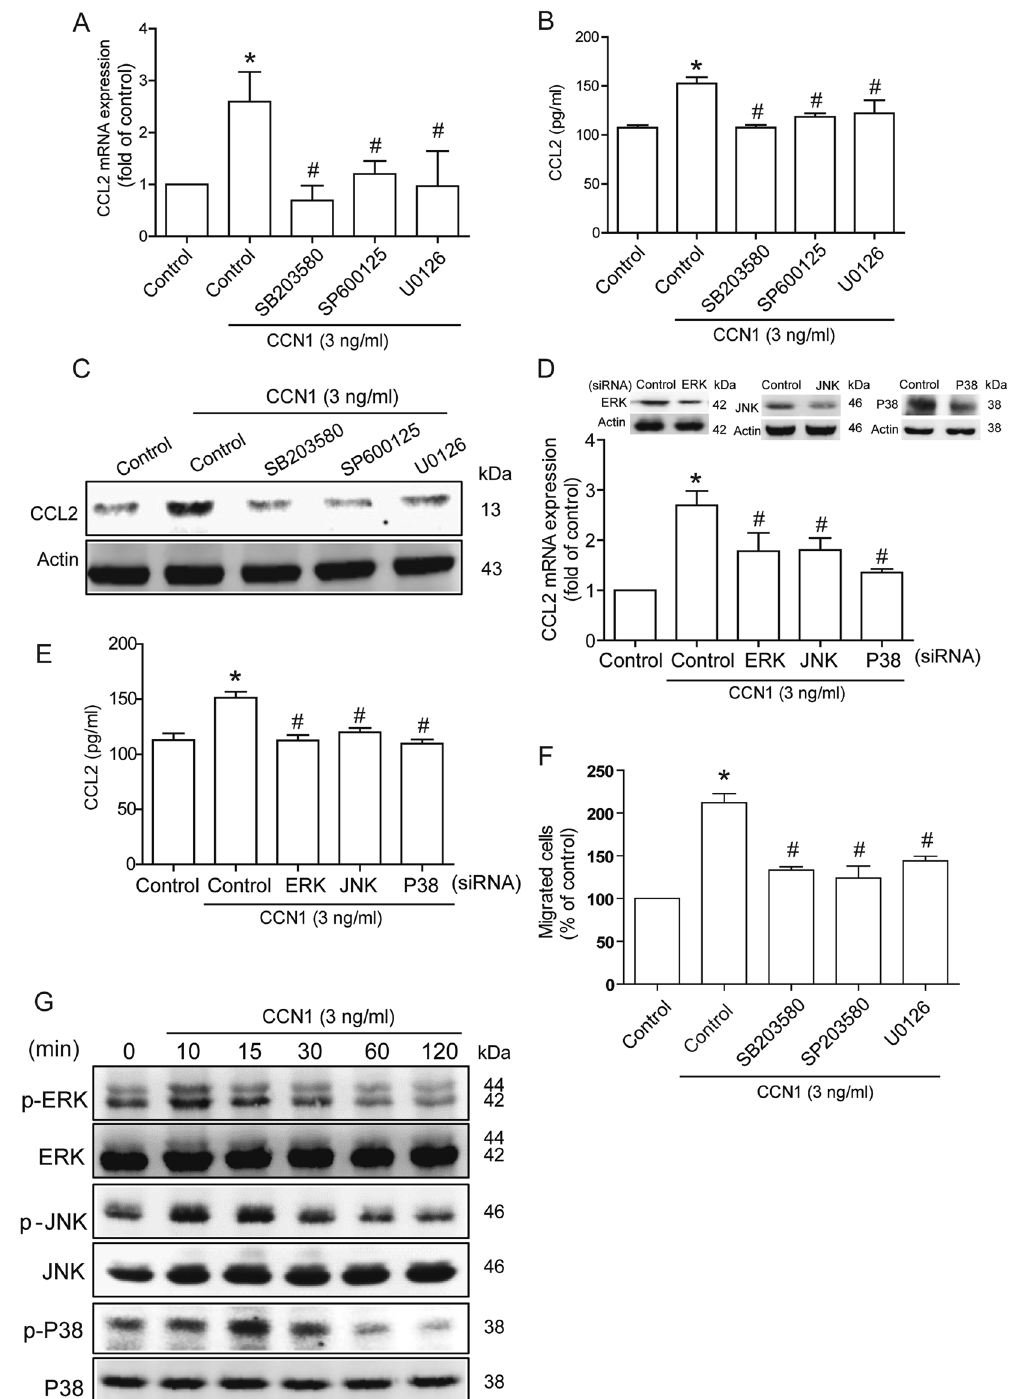
Figure 3. The MAPK signaling pathway is involved in CCN1-induced CCL2 expression. ( A – E ) MG63 cells were pretreated with SB203580 (10 μ M), SP600125 (3 μ M), or U0120 (10 μ M) for 30 min, or transfected with ERK, JNK, and p38 siRNA for 24 h, followed by stimulation with CCN1 for 24 h. CCL2 expression was examined by qPCR, ELISA and Western blot analysis (n = 5 per group). ( F ) Medium was collected as CM, and THP-1 migration was assessed by in vitro chemotaxis assay (n = 5 per group). ( G ) MG63 cells were incubated with CCN1 (3 ng/ml) for indicated time intervals, and ERK, JNK, and p38 phosphorylation was examined by Western blot analysis (n = 4). Results are expressed as the mean ± S.E. * p < 0.05 compared with